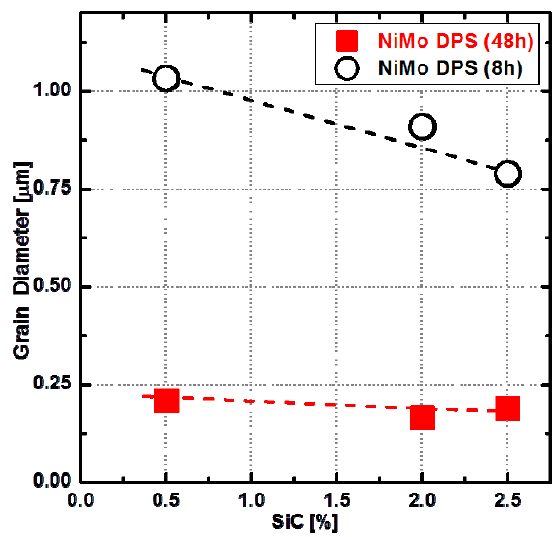
Figure 8. Variations of average grain diameters in 48-h-milled and 8-h-milled NiMo-SiC DPS alloys with SiC contents from 0.5 to 2.5 wt % in the initial powder mixture.